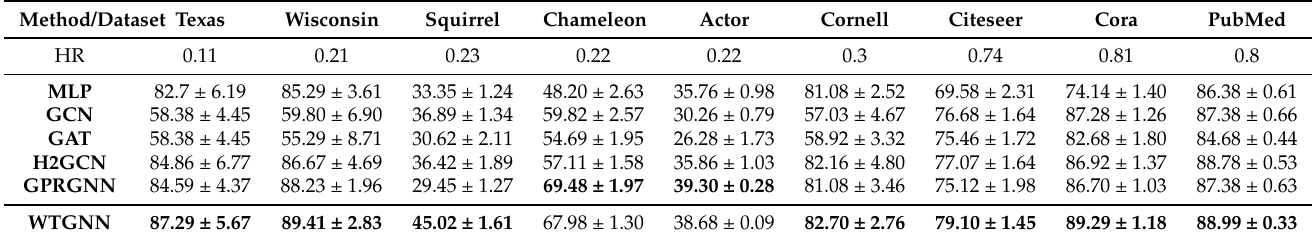
Table 5. Mean accuracy(%) ± stdev over different data splits.